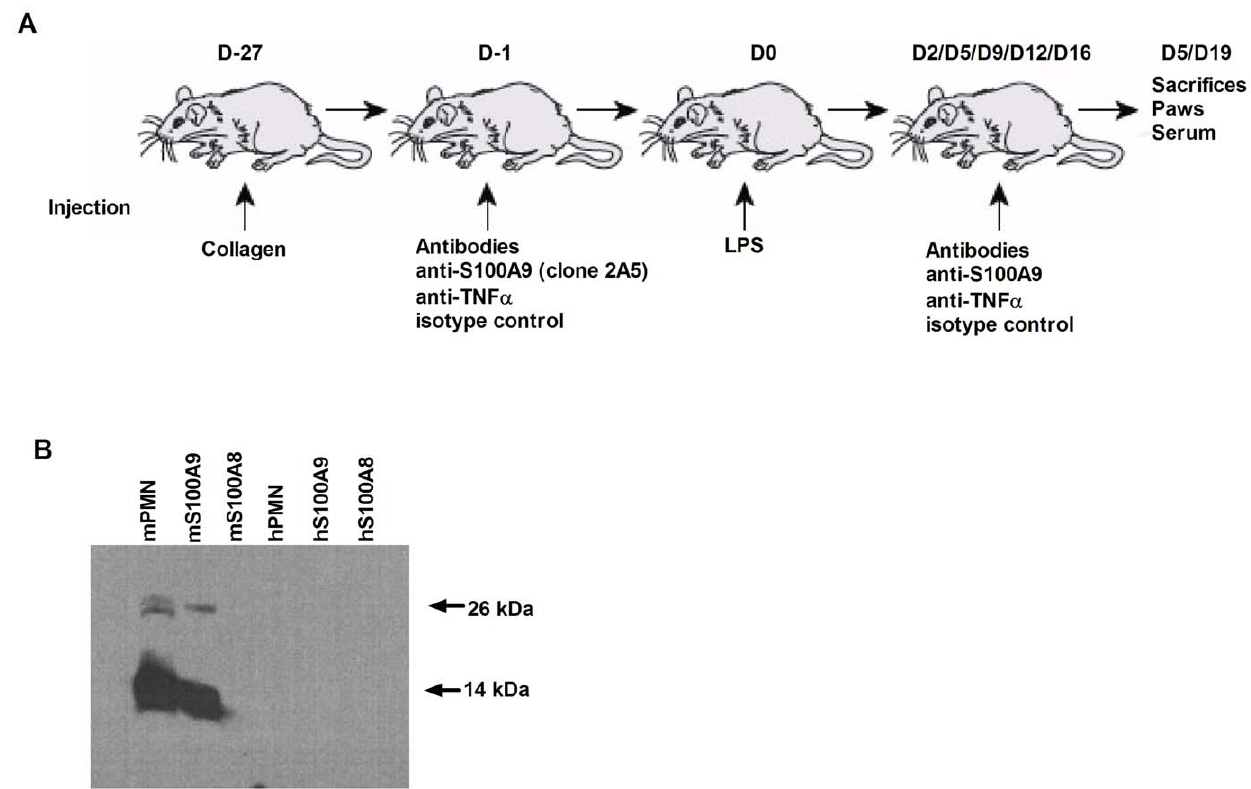
Figure 1. LPS-CIA model. (A) Mice (25 mice/group) were immunized at the base of the tail with 100 m g of chicken type II collagen on day ‘‘ 2 27’’ and then injected i.p. with LPS (25 m g in PBS) on day 0. Two milligrams of neutralizing Abs or isotype control Abs were injected into mice 24 h before LPS injection. During the protocol, five injections were given, at 2, 5, 8, 12, and 16 days post-LPS injection. On day 5 and 19, mice were sacrificed to collect the paws and the serum for further analysis. (B) Murine monoclonal anti-S100A9 (Clone 2A5) was tested for specificity by western blot against murine protein mS100A9, mS100A8, a lysate of murine neutrophils, human protein hS100A12, hS100A9, hS100A8 and a lysate of human neutrophils.